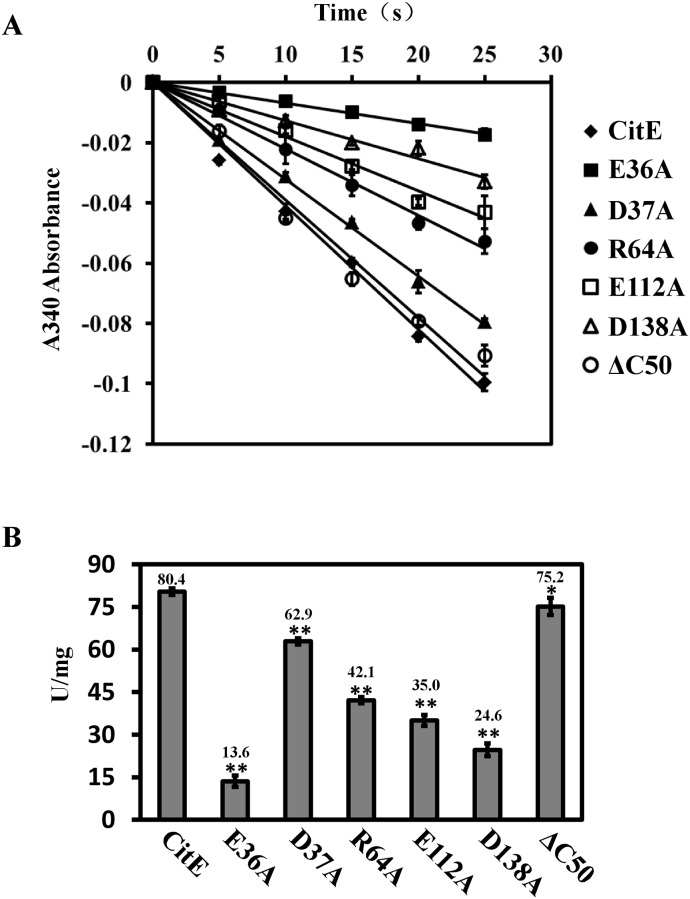
Comparison of citrate cleavage activity between wild-type MtbCitE and its mutants.(A) The linear plot reveals the trends of citrate cleavage by wild-type MtbCitE and its mutants. The line in the graph shows the trend of NADH oxidation rate, which represents the enzyme activity of MtbCitE and its mutants. Diamond, wild-type CitE protein; close square, E36A; close triangle, D37A; close circle, R64A; open square, E112A; open triangle, D138A; open circle, ΔC50). The diagram shows the mean values of A340 absorbance from three independent replicates ± standard deviations. (B) The bar chart reveals the citrate cleavage activity units of wild-type MtbCitE and its mutants. The values presented are the average values of three independent experiments, and the error bars represent the variant range of the data derived from three replicates. The P-values of the results were calculated by one-way ANOVA. A significant difference between two proteins was indicated by an asterisk (*, P<0.05) or a double asterisk (**, P<0.01) in the figure.